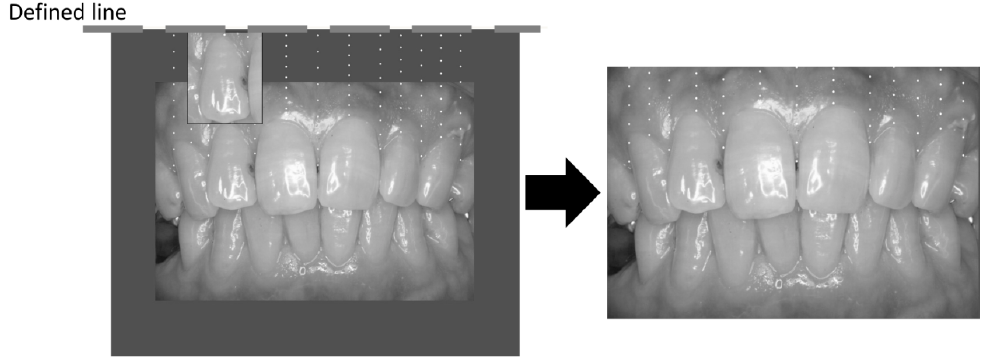
Figure 1. Measurement of gingival pigmentation (gingival melanosis record).